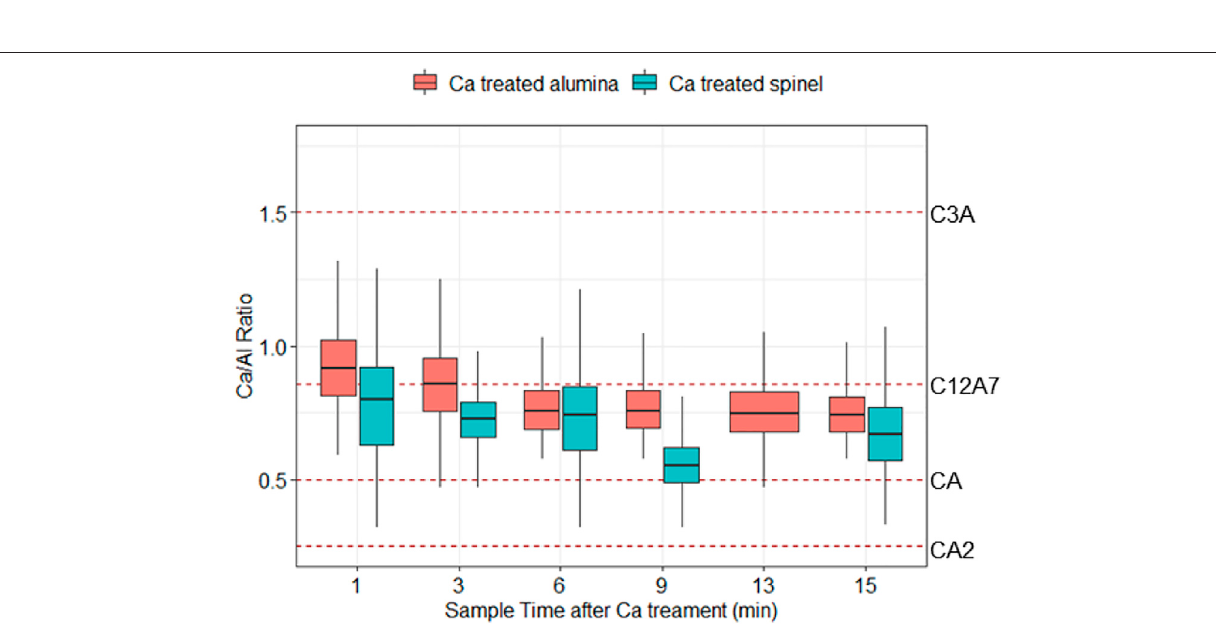
Frontiers in Materials |